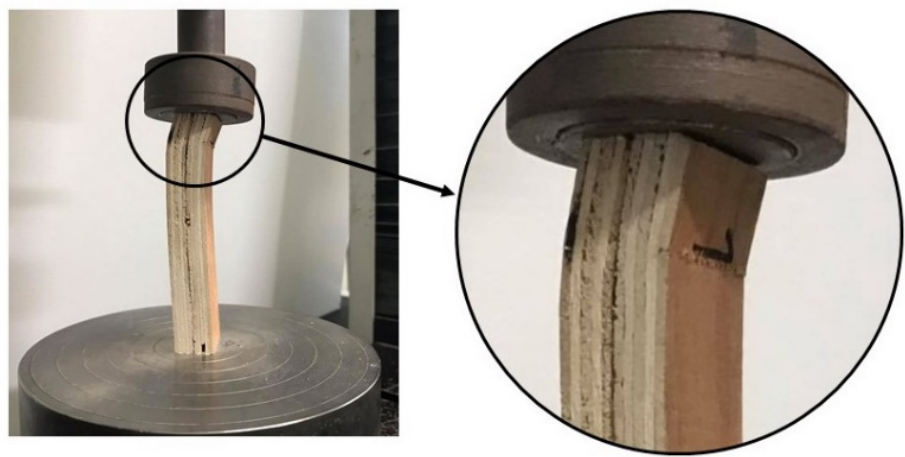
of the surface materials.